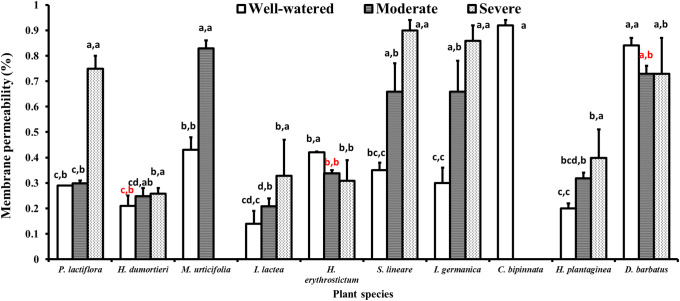
Variance of the membrane permeability for the ten species under drought stress.The histogram shows the mean values. Above the histogram, the lowercase letters before the commas indicate statistical significance among the different plant species, and those after the commas indicate statistical significance among the well-watered, moderate and severe drought stress treatments. The different lowercase letters indicate a significant difference at P<0.05.